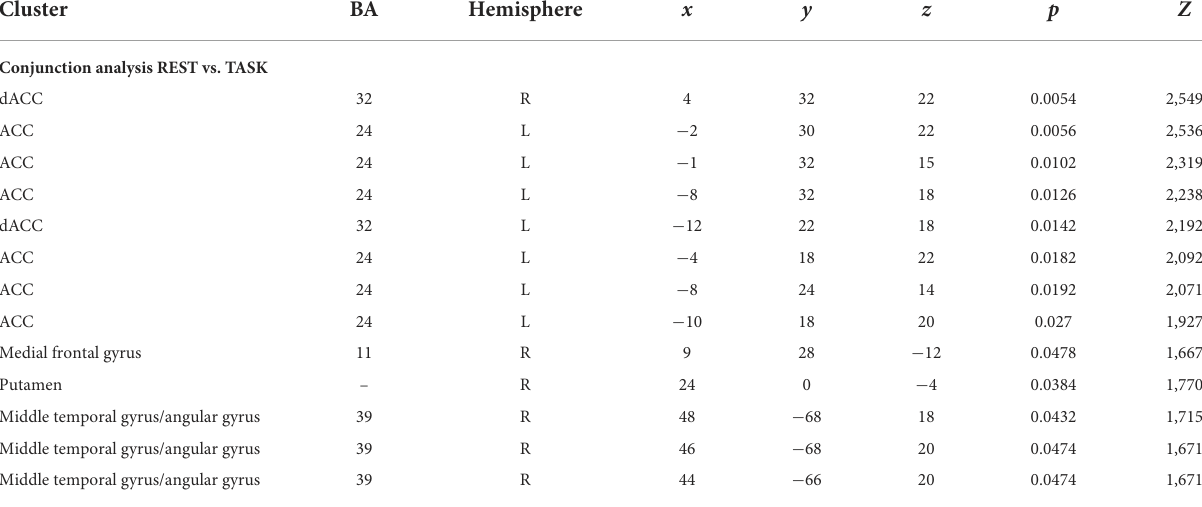
TABLE 3 Brain clusters resulting from the conjunction analysis between resting state and task based studies.